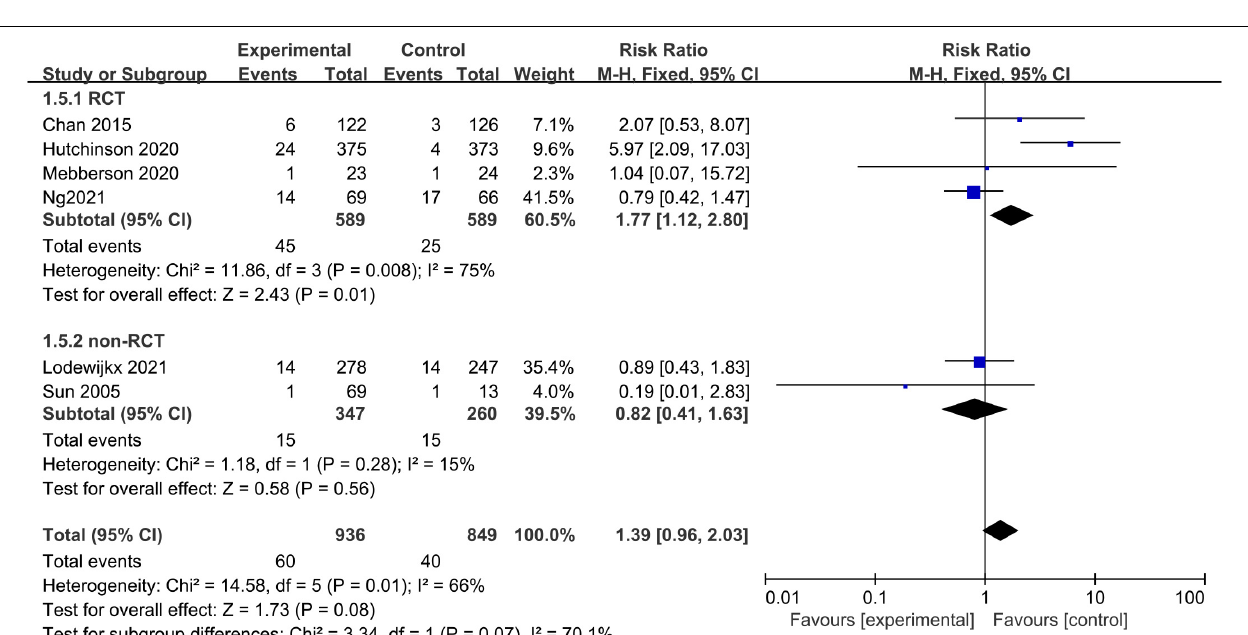
Frontiers in Neuroscience |